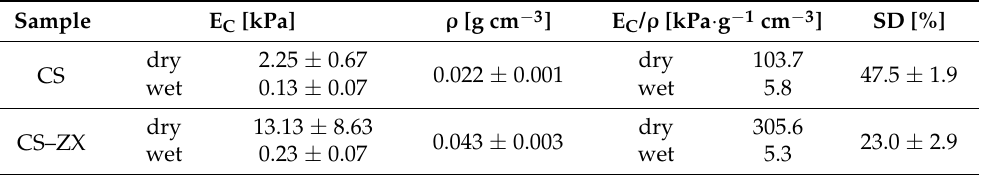
Figure 5. Representative compression stress–strain curves for CS in dry ( a ) and wet ( c ) conditions and for CS–ZX in dry ( b ) and wet ( d ) conditions. The arrows indicate loading (continuous lines) and unloading (dashed lines) cycles carried out by setting different values of maximum deformation (20%, 50% and 70%). Each loading–unloading cycle was performed on a distinct sample. Table 1. Values of compressive elastic modulus, specific compressive elastic modulus density and swelling degree.